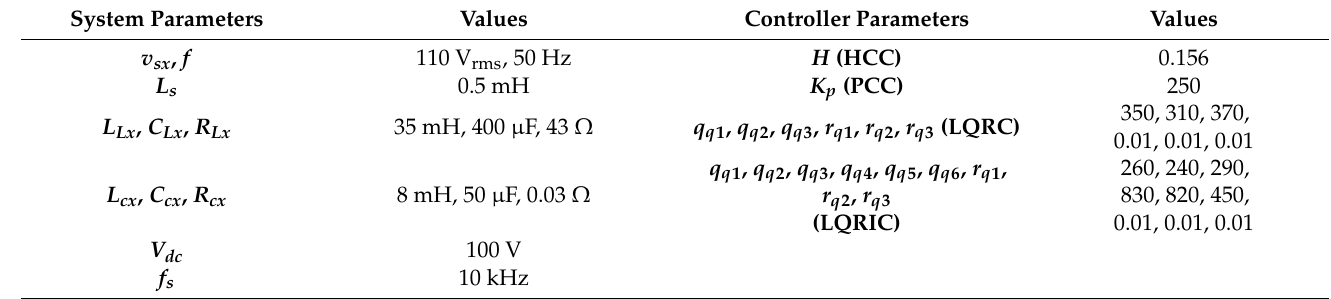
Table 1. System parameters and control parameters of different controllers for simulation.